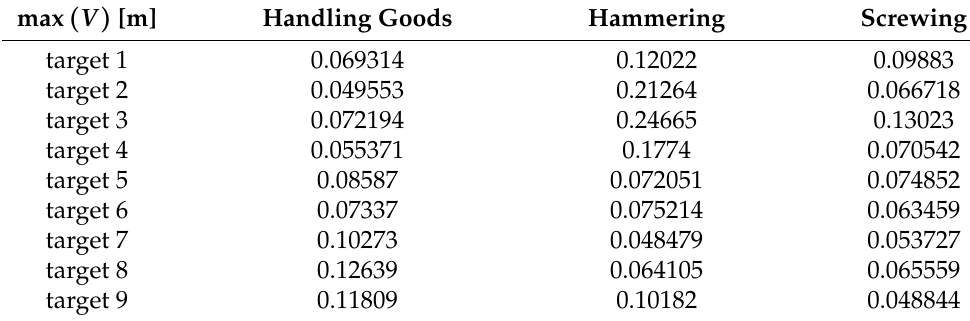
Table 5. Intra-subject variability.